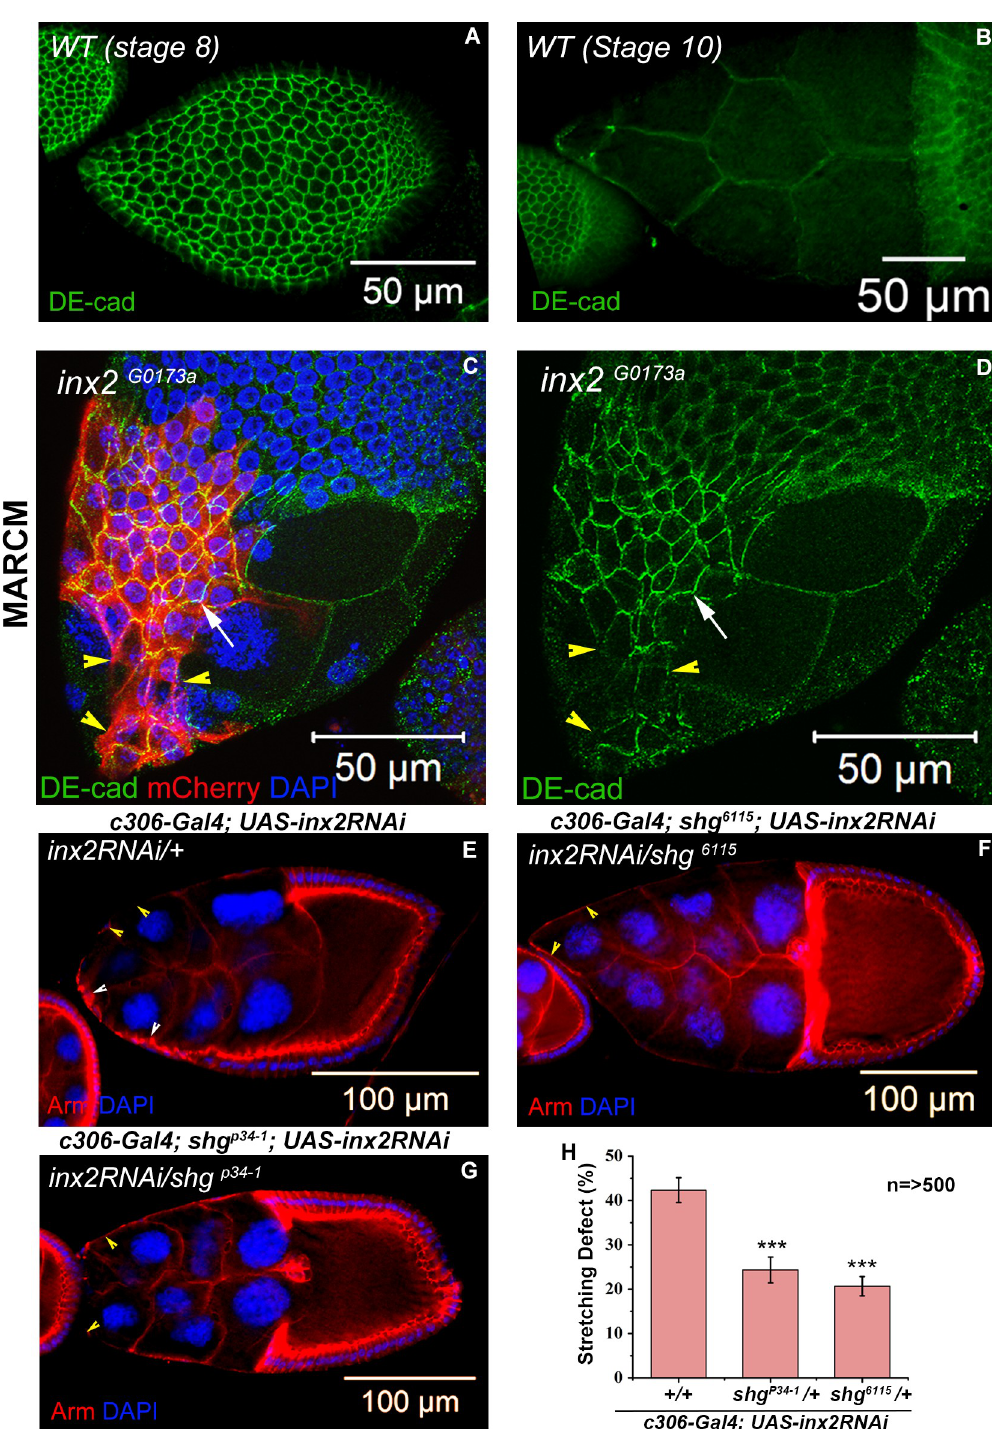
Fig 6. Inx2 modulates shape transition possibly via changes in the levels of DE-Cadherin. (A-B) Wild type ( WT ) egg chambers stained with anti-DE-Cadherin shown in Green. Note that unlike the squamous cells in B, DE-Cadherin is enriched in the cuboidal follicle cells in A. (C-D) MARCM analysis. Stage 10 egg chambers carrying clones of inx2 G0173a mutant follicle cells, which are marked with mCherry in Red. Note the retention of E-Cadherin in the unstretched follicle cells (Arrow). Yellow arrow head marks the interface of clone and nonclone boundary where DE-Cadherin is downregulated. (E-H) Partial rescue of stretching defect is seen in shotgun/ DE-cadherin heterozygous background. (E-G) Stage 10 egg chambers